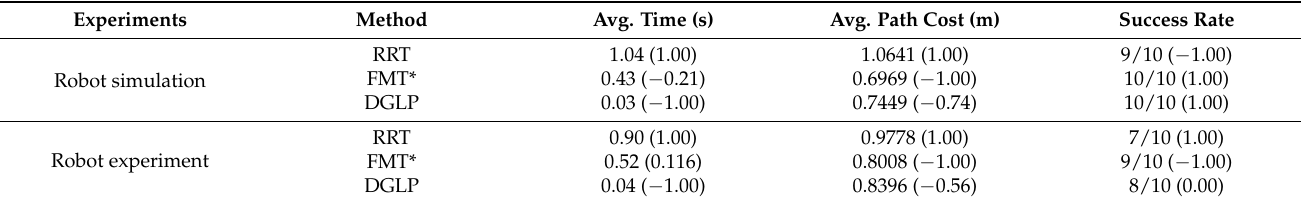
Table 2. The experimental results for dynamic local path